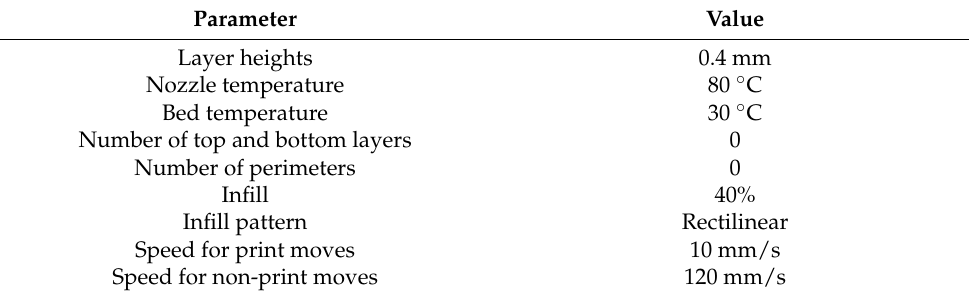
Table 4. 3D-printing slicing